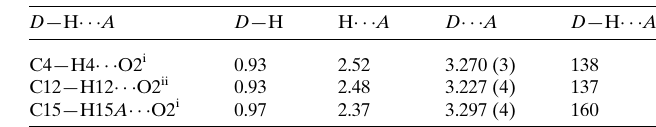
Table 1 Hydrogen-bond geometry (A˚ , (cid:2) ).